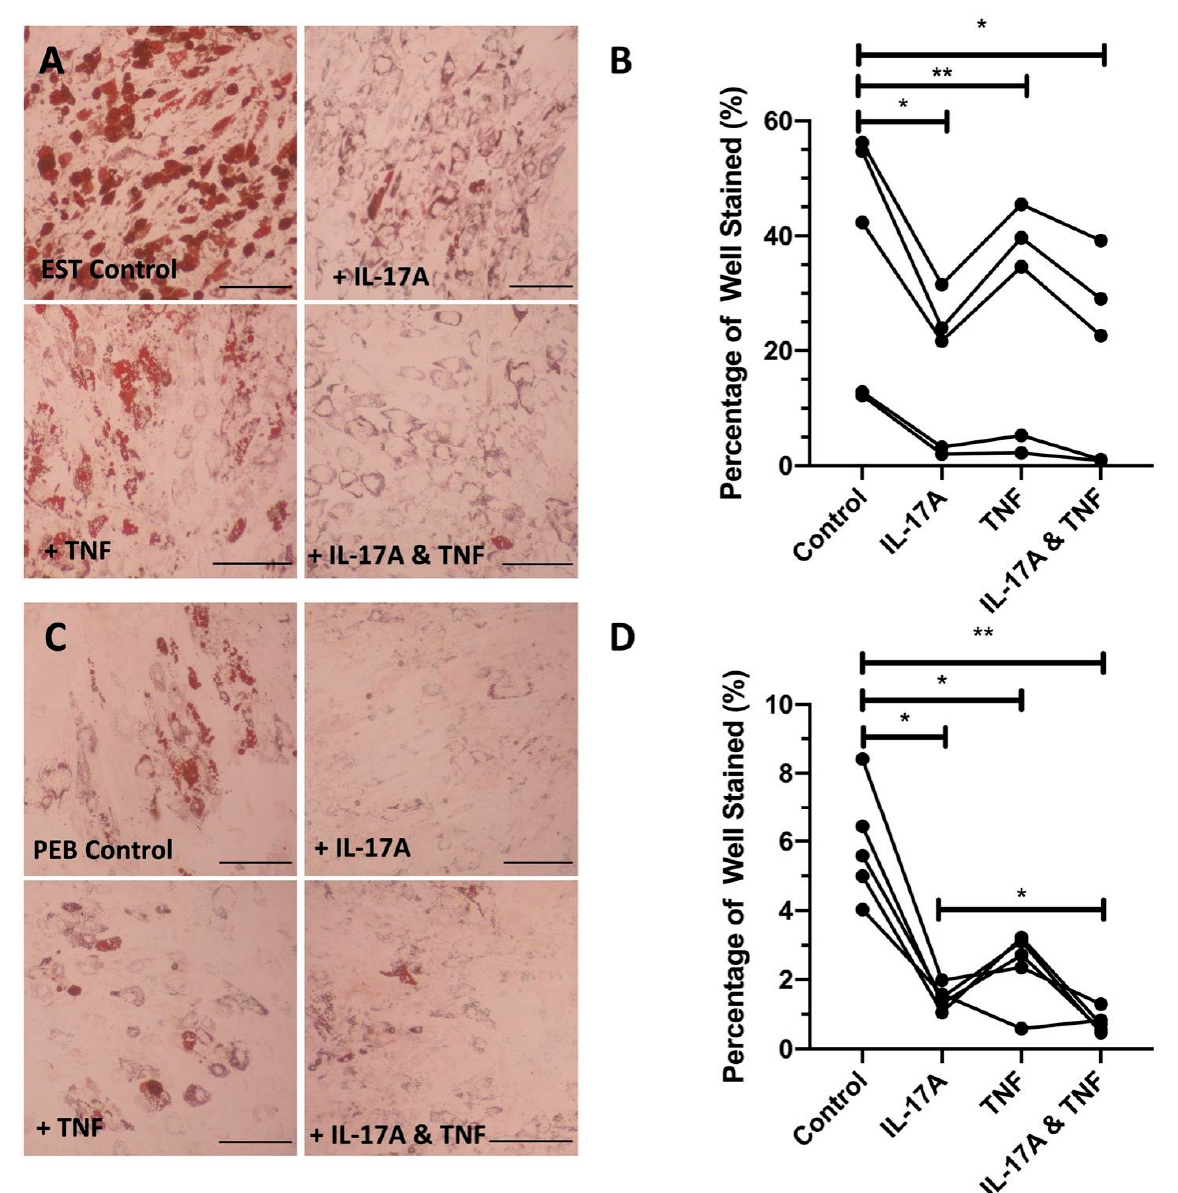
Figure 2. Representative images showing the cytokine inhibition of adipogenesis in both entheseal soft tissue (EST) ( A ) and peri-entheseal bone (PEB) ( C ) mesenchymal stem cells (MSCs). Quantified significant reductions in adipogenesis by IL-17A, tumout necrosis factor (TNF), and co-stimulation with both IL-17A and TNF in both EST (( B ), RM One-Way ANOVA with Tukey Post-Hoc Test, n = 5) and PEB (( D ), RM One-Way ANOVA with Tukey Post-Hoc Test, n = 5) MSCs. IL-17A used at 50 ng/mL and TNF at 1 ng/mL. * = p < 0.05, ** = p < 0.01. Scale bar = 250 μ m.